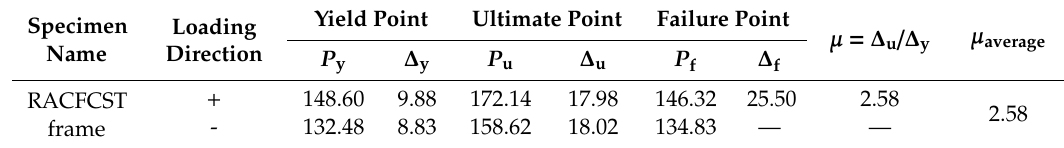
Table 5. The measured load and displacement at characteristic